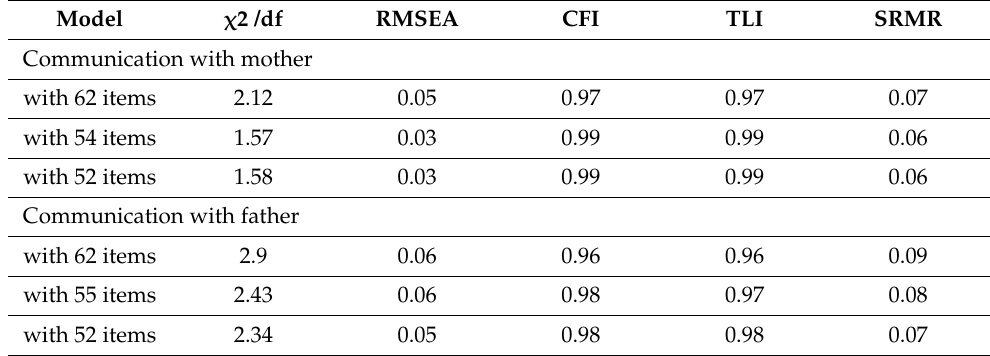
Table 3. Fit indexes of different